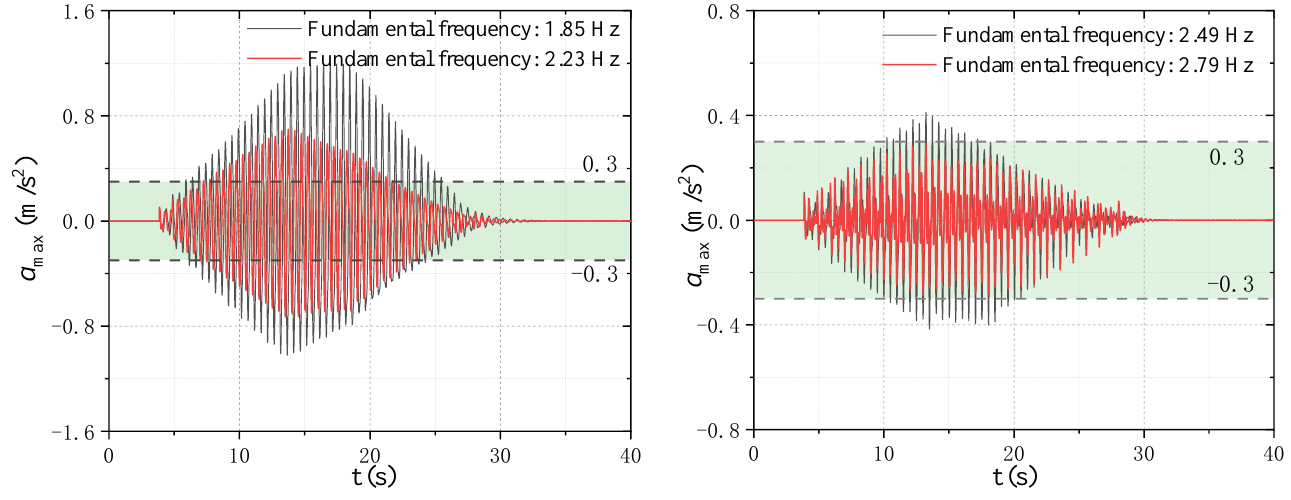
Figure 18. Time history of lateral acceleration in mid-span. Table 4. Lower limit of horizontal fundamental frequency of different